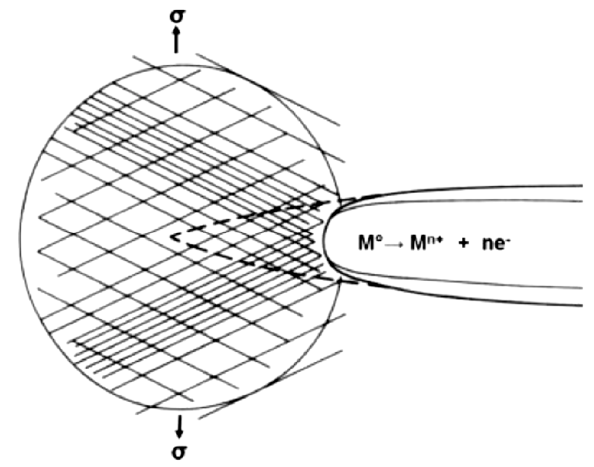
Figure 4. Continuous crack propagation according to the film rupture model. Reproduced with permission from [75], John Wiley and Sons, 2005.